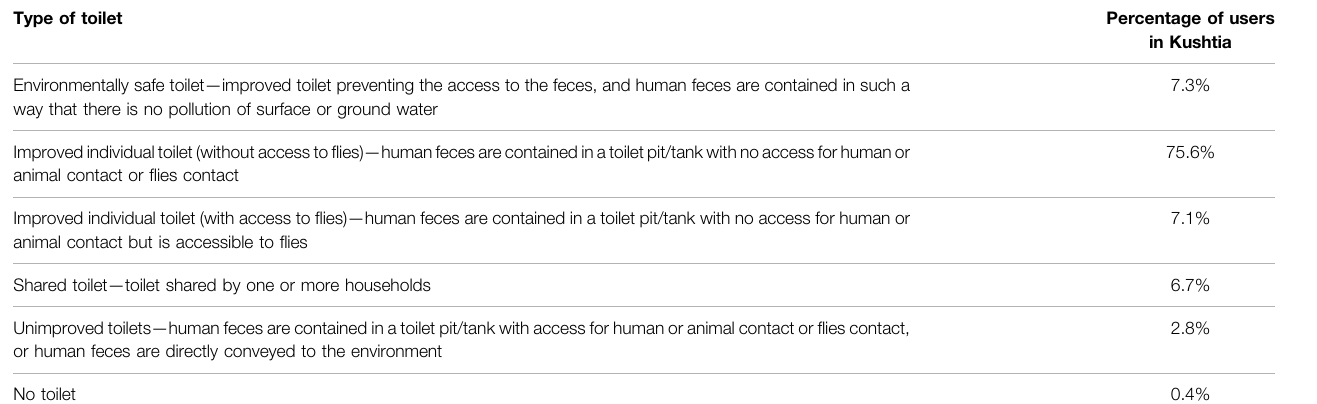
TABLE 5 | Toilet typology in Kushtia